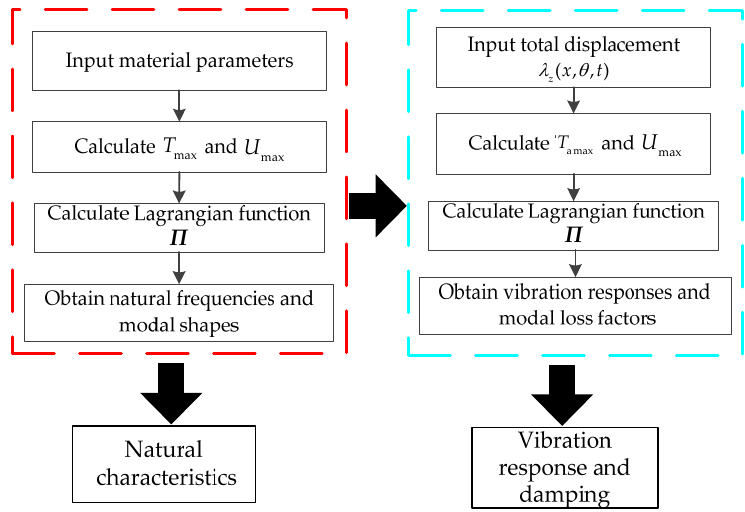
Figure 2. Vibration characteristics analysis procedure of FCTS with hard coating.